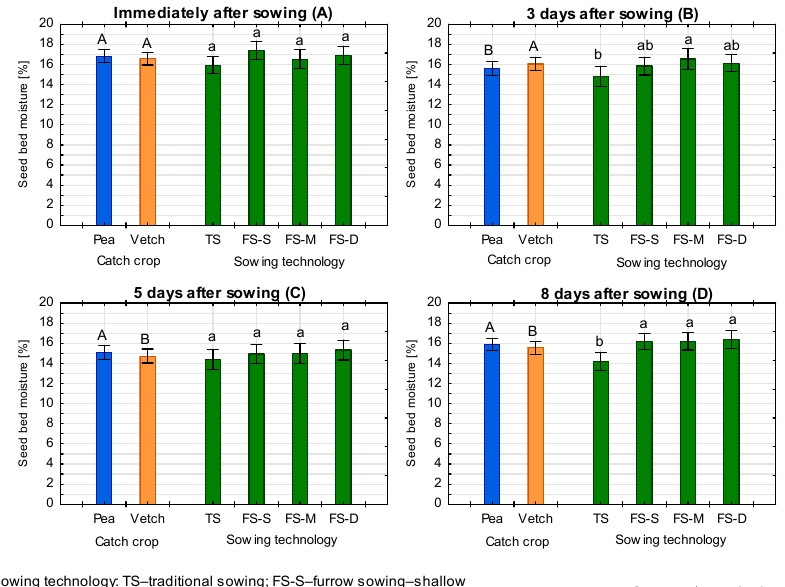
Figure 3. Seed bed moisture content during seed germination [% vol]—average for 2016–2018. a,b—the same small letter for different sowing methods indicates the lack of significant differences between means ( p = 0.05). A,B—different capital letter for different crops indicates significant differences between means ( p = 0.05).